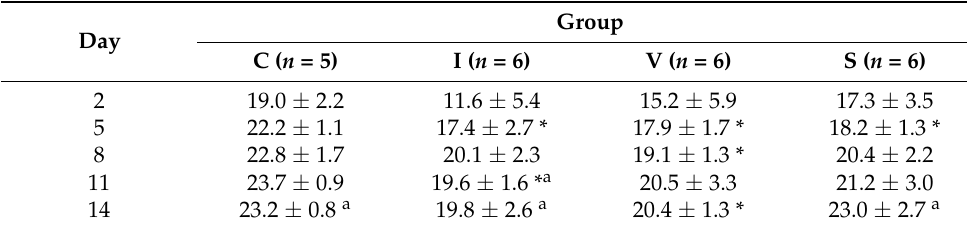
Table 2. Food intake (g/day) of rats in the control group and the three immobilization groups for 14 days.